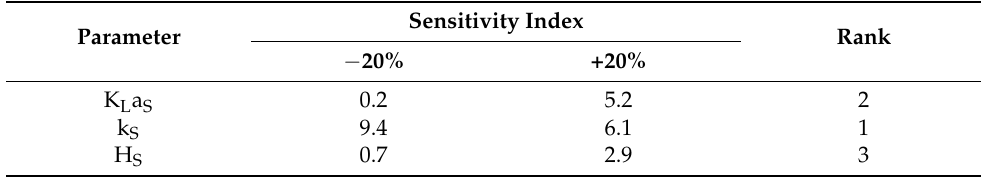
Table 2. Sensitivity index for H 2 S